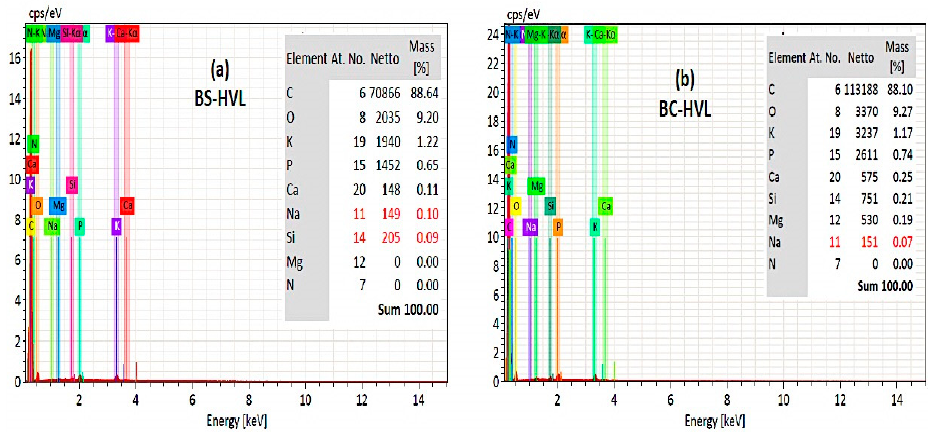
Figure 7. EDXA (energy dispersive X-ray analysis) diffractograms after adsorption of the BS-HVL ( a ) and BC-HVL ( b ).